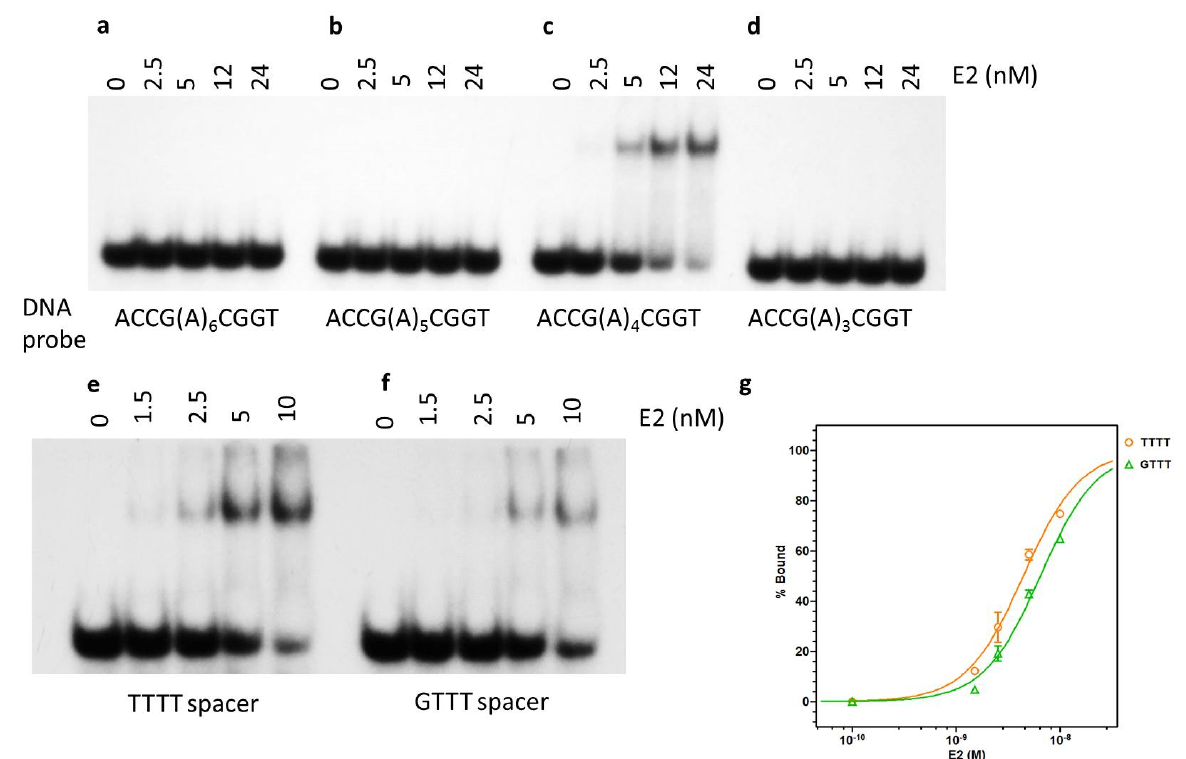
Figure 5. Binding of E2 to DNA binding site with altered spacer lengths and sequence. ( a – d ) Oligonucleotides containing E2 BS1 with varying lengths of the spacer, (A) x , where X refers to the number of adenine residues used to examine the roles of spacer length. EMSA was performed with titration of E2 protein as indicated. ( e ) Oligonucleotides contained HPV-11 E2 BS4 with either its native TTTT spacer or ( f ) spacer of BS3 (GTTT). E2 protein was titrated to each probe, with protein concentrations as indicated. ( g ) Quantitative analysis of the data derived from e , and f .